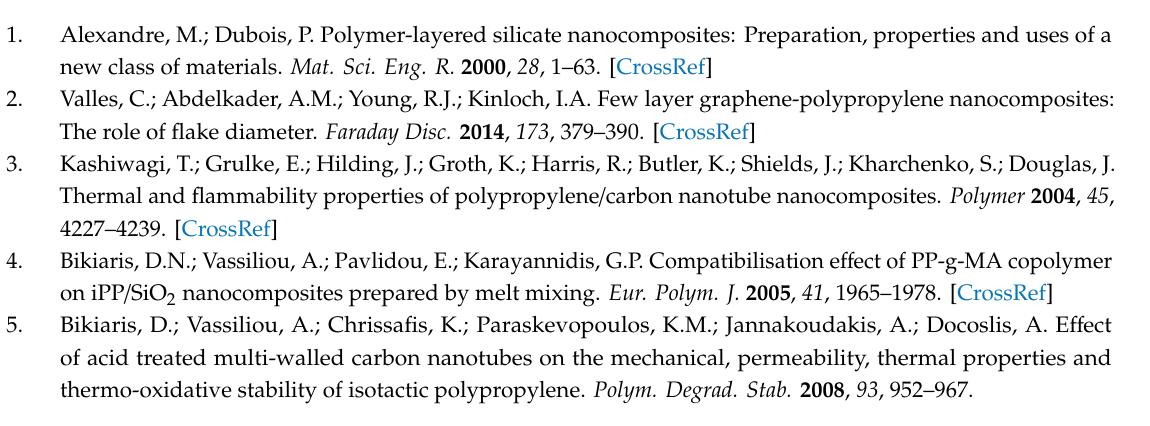
Supplementary Materials: The supplementary materials are available online, Table S1: Avrami parameters of PP and the composite samples at di ff erent isothermal crystallization temperatures, Figure S1: (a) Avrami exponent of PP and nanocomposites. The n values of the matrix have been plotted using both symbol and line in order to separate them easier from the values of the composites; (b) growth function K of all materials under study, Figure S2.: Evolution of the crystallization peak temperature as a function of cooling rate for PP and